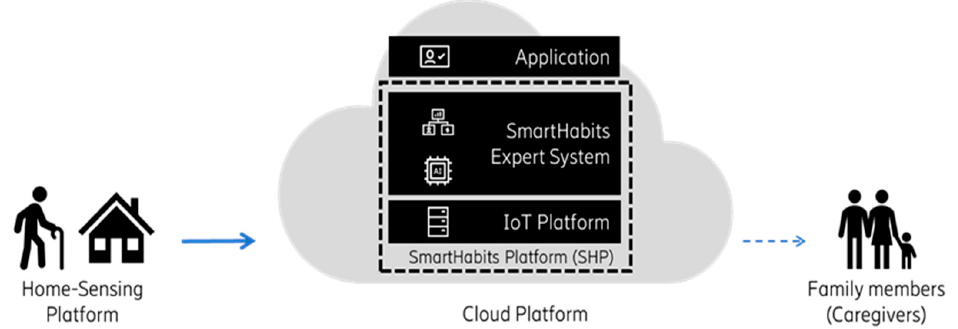
Figure 1. SmartHabits system overview. Adapted from ref. [13].